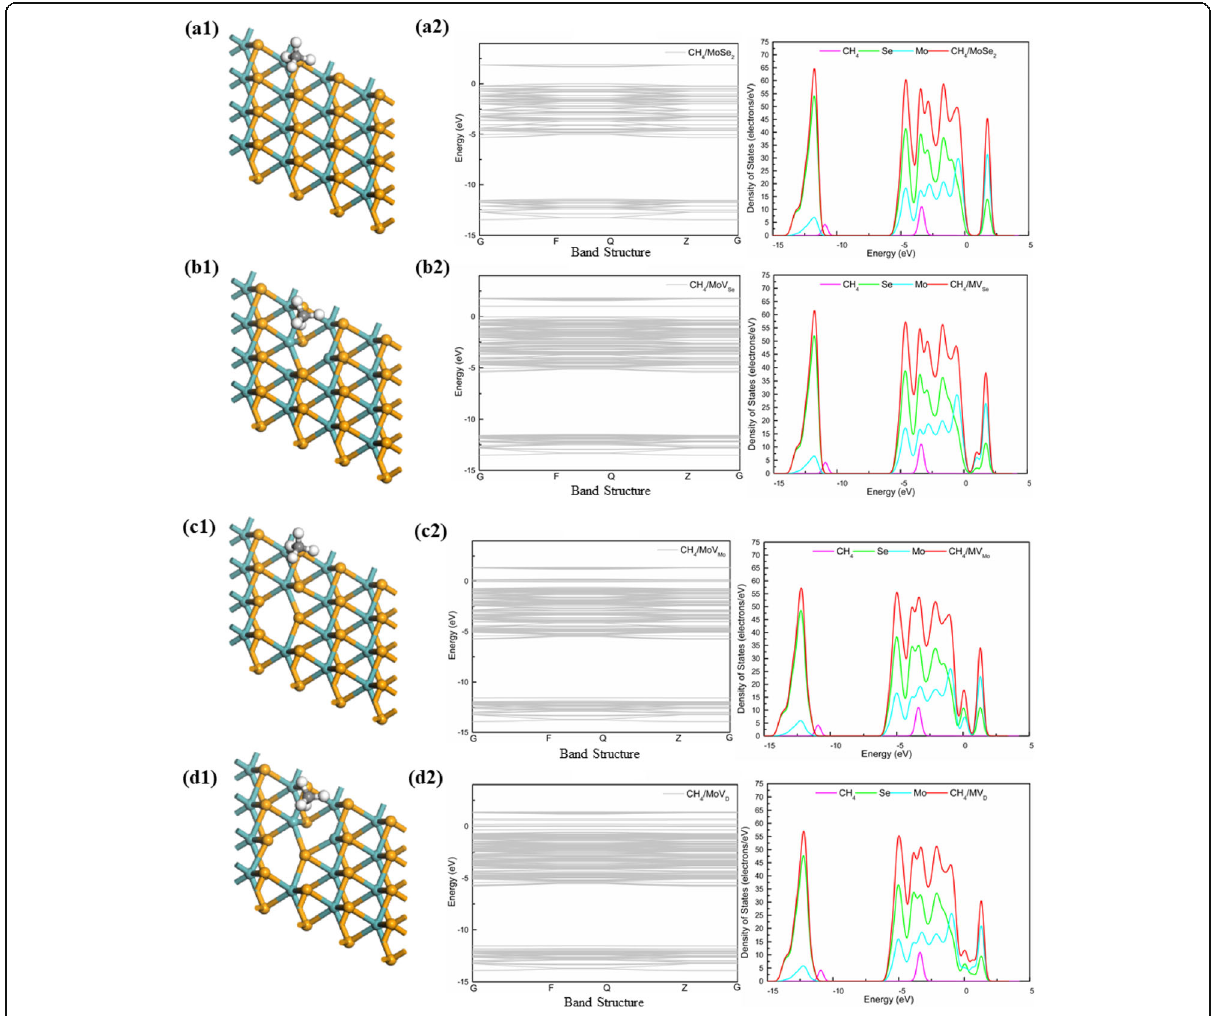
Fig. 5 The structure and DOS of CH 4 gas molecule on four systems (MoSe 2 , MV Se , MV Mo , and MV D